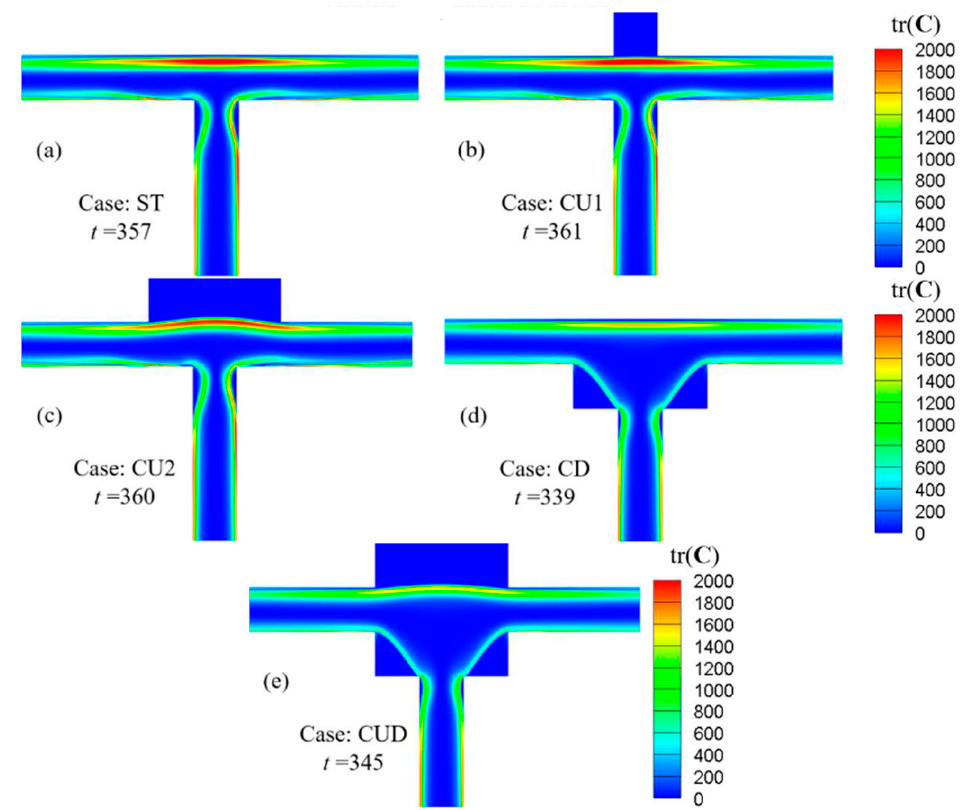
Figure 10. Distribution of the trace of conformation tensor tr( C ) for various geometries at the instant with the largest flow rate in Figure 9. For all cases, 𝛽 = 0.5 , Wi = 5 .